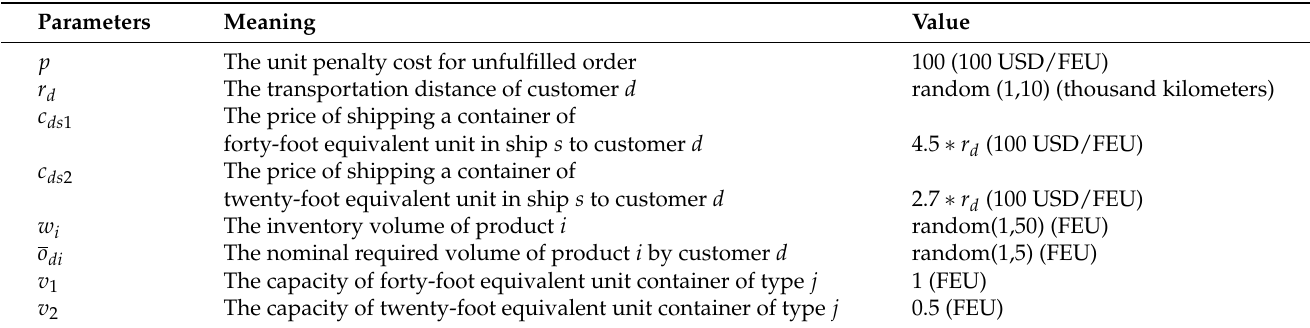
Table 2. Key parameters used to generate random